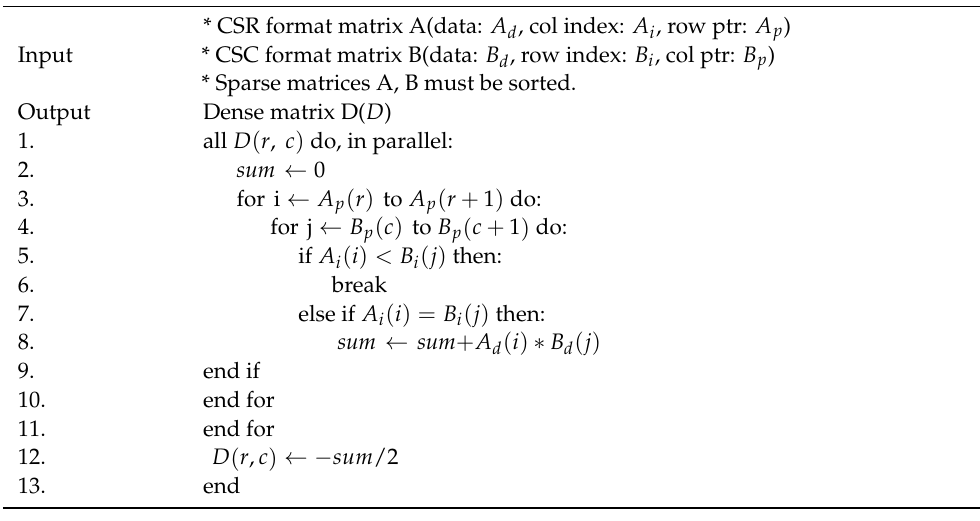
Algorithm 2. Parallel Sparse-Matrix Multiplication